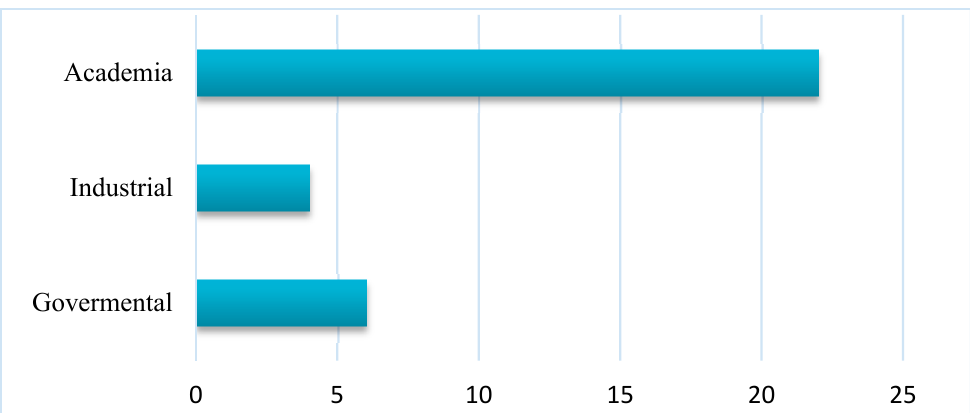
Figure 2. Literature overview: the number of the organization for SWS’s definition.